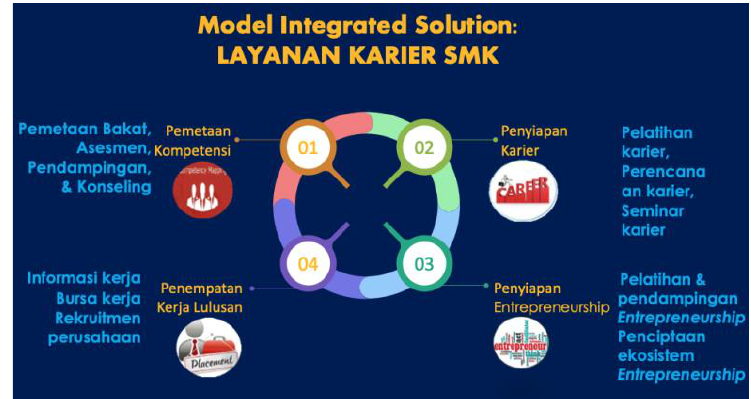
Figure 9: The Digitalization Model of the Integrated Career Service Program for Vocational High